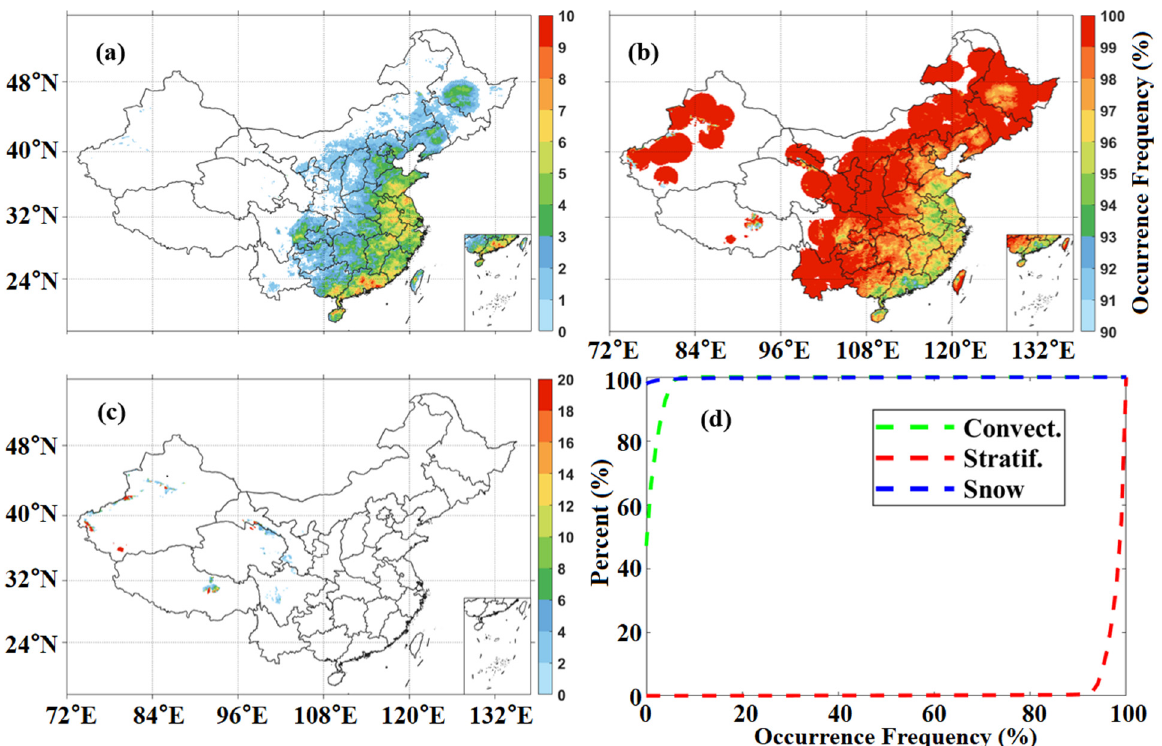
Figure 3. Spatial distribution of frequency of ( a ) convective, ( b ) stratiform, and ( c ) snow over China during summer. ( d ) Cumulative probability distribution of occurrence with different precipitation types during summer.